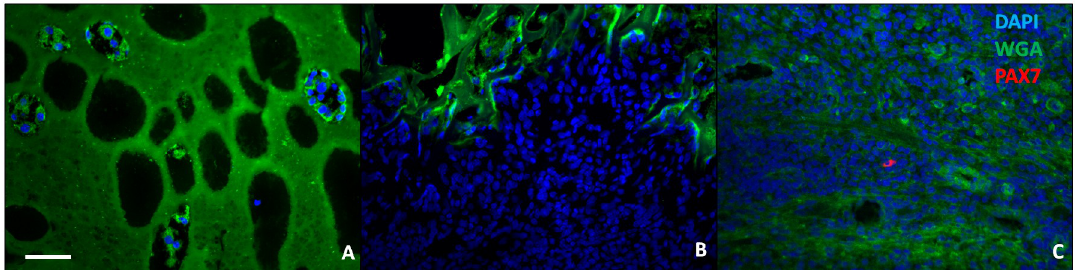
Fig 5. Representative sectionsfrom a 2 week TA muscle explantstreated with low OA gel showedthat no PAX7+ satellite cells were obsereved in the center of the defect (A) or at the edge of the defect (B). PAX7+ cells were occasionally observed in the host muscle in proximity to the defect edge, which is likely tissue that was injuredduringsurgery (C). Scale bar = 100 μ